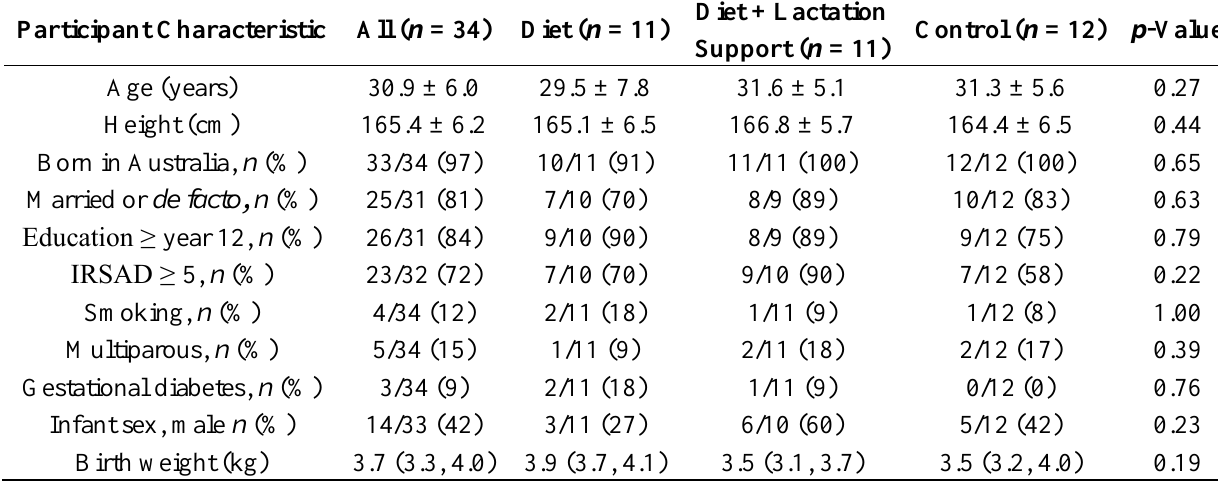
Table 1. Baseline characteristics and birth data for pilot randomised controlled trial participants. Participant